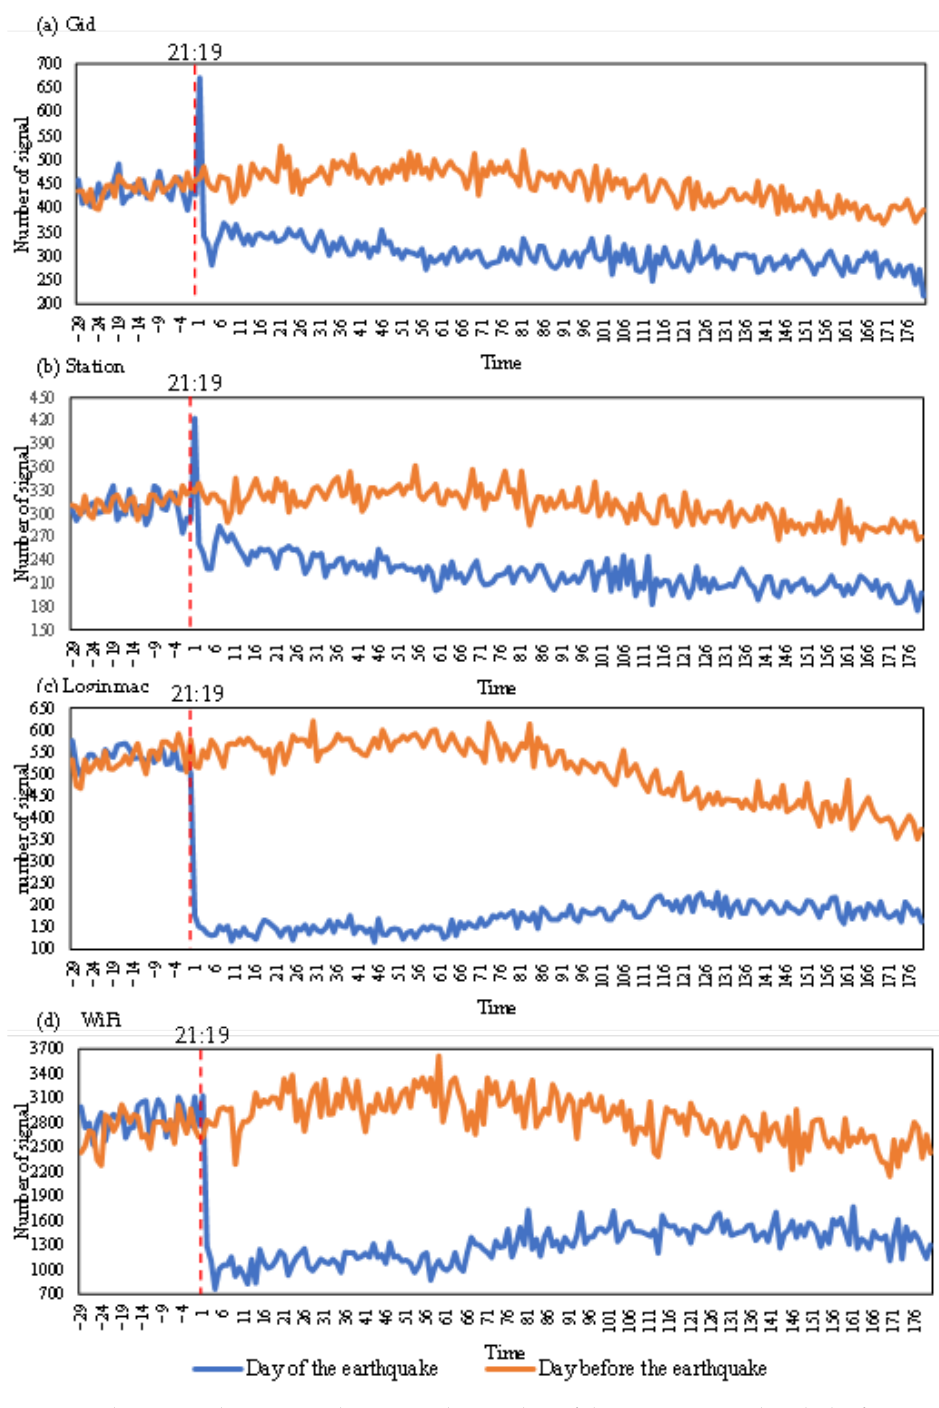
Figure 2. The minute-by-minute changes in the number of devices associated with the four types of signaling data. On the horizontal axis, 1 represents 1 min after 21:19, i.e., 21:20; 2 represents 2 min after 21:19, i.e., 21:21, . . . , and 180 represents 0:19 the next day. − 1 represents 1 min before 21:19, i.e., 21:18, 2 represents 2 min before 21:19, i.e., 21:17, . . . , and − 29 represents 20:50.